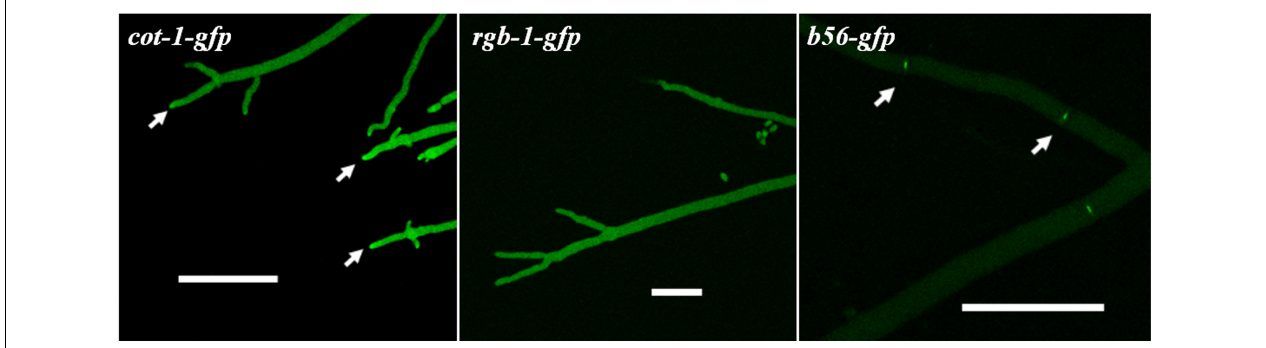
FIGURE 8 | RGB1::GFP and B56::GFP predominantly localize to the hyphal tip and septa, respectively (marked by arrows), as determined by confocal microscopy. COT1 localization is presented for comparison. Bars indicate 50 µ m.